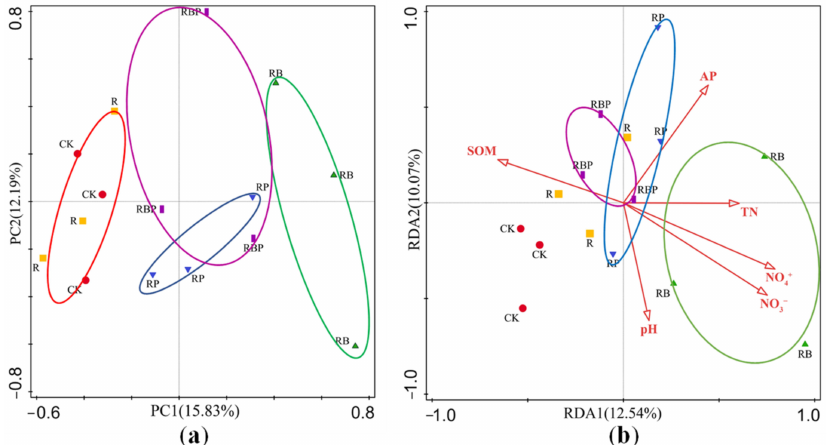
Figure 3. ( a ) Principal component analysis (PCA) between functional composition. ( b ) Redundancy analysis (RDA) between functional composition and soil properties, TN (total nitrogen), AP (available phosphorus) and SOM (soil organic